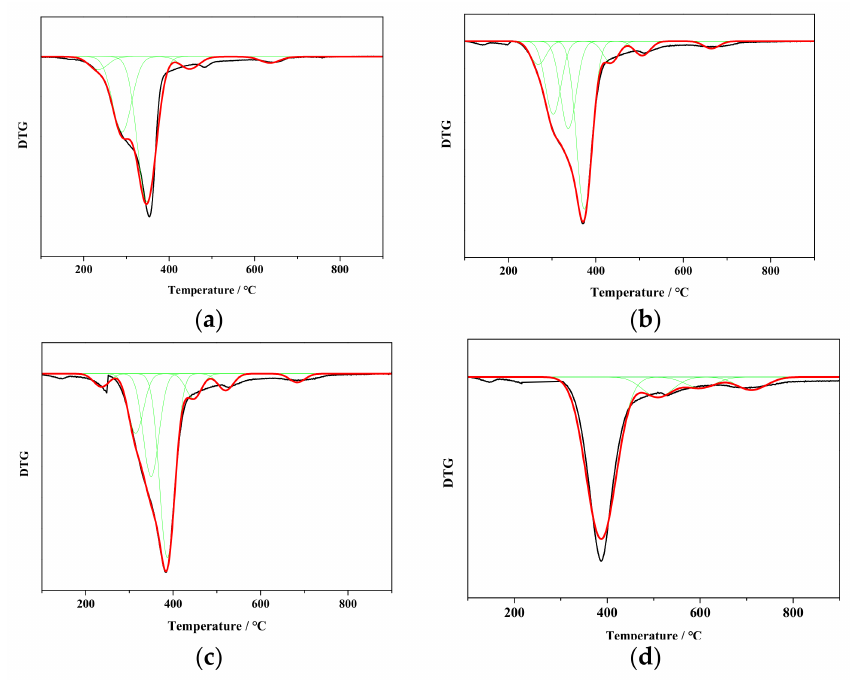
Figure 4. DTG fitting curves of raw and torrefied cedar. (( a )—cedar, ( b )—C-200, ( c )—C-250, ( d )—C- 300). Green line: Fitting peak curve; Red line: Fitting curve; Black line: Raw